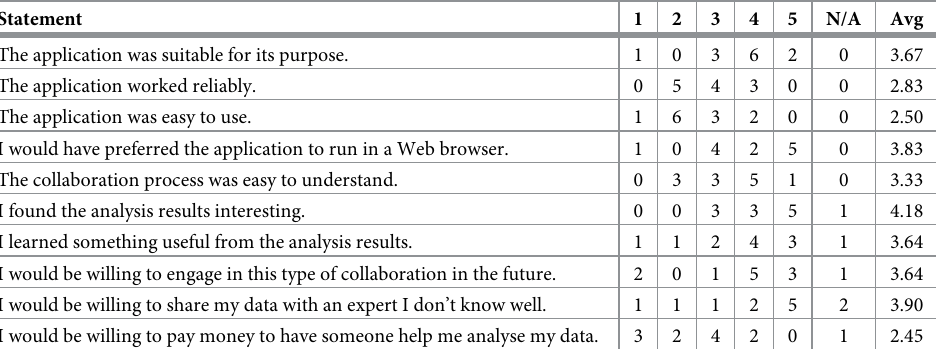
Table 5. Number of survey respondents by level of agreement with various statements.